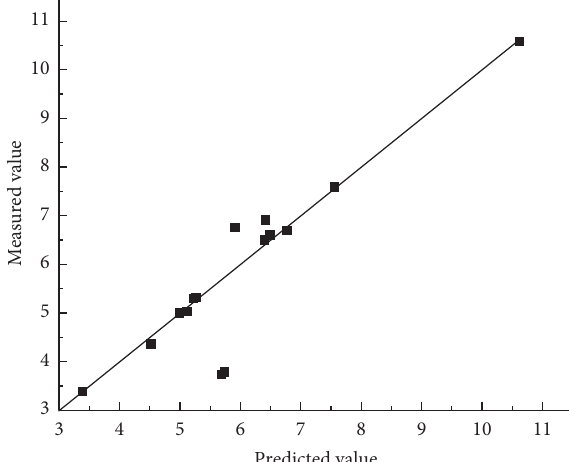
Figure 5: Ratio of measured value and predicted value of displacement ductility coefficient (Table 7).